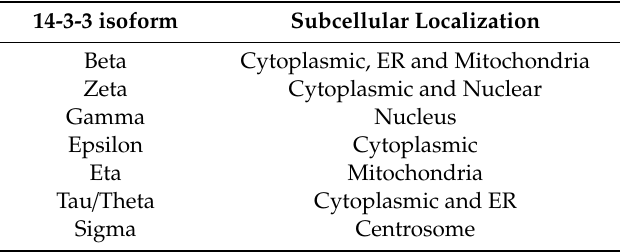
Table 1. The summary of the subcellular localizations of seven 14-3-3